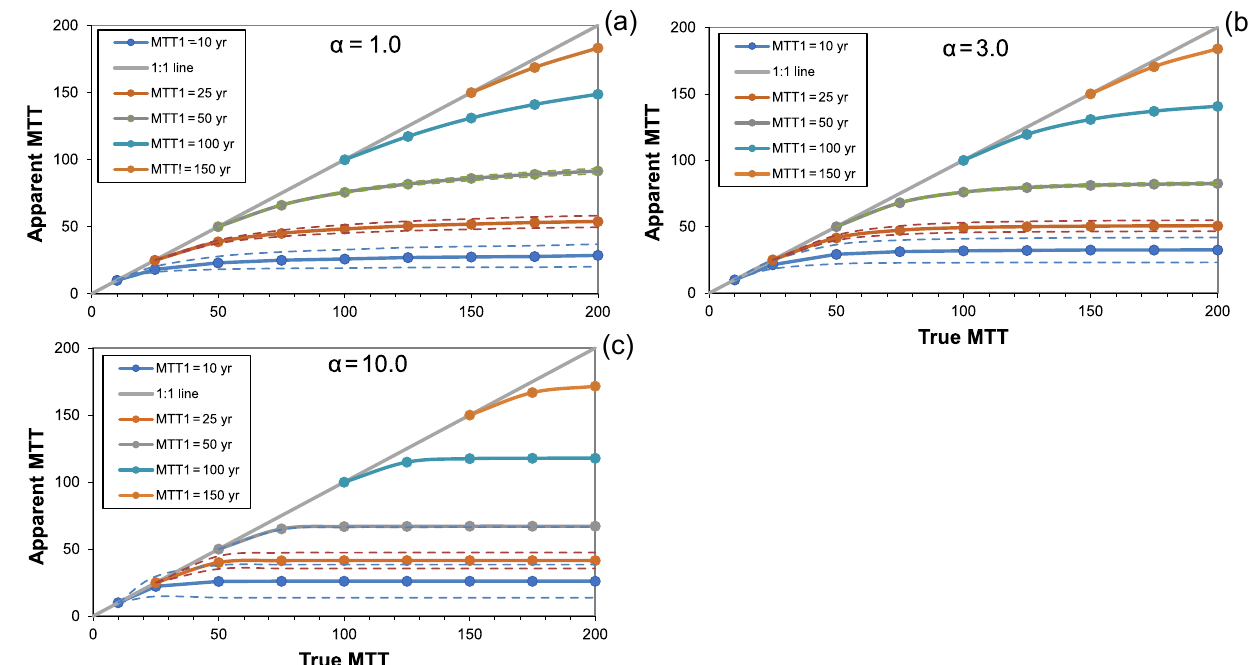
Figure 5. Aggregation effects for tritium MTTs for GMs with different values of α using the Kaitoke input function. Curves show changes as component 2 (MTT2) becomes older in 50-year steps and therefore the mixtures older in 25-year steps (shown by dots). The first step of the MTT1 = 10 years curve is 15 years. Fitting errors in the apparent MTTs are shown by fine dashed lines.